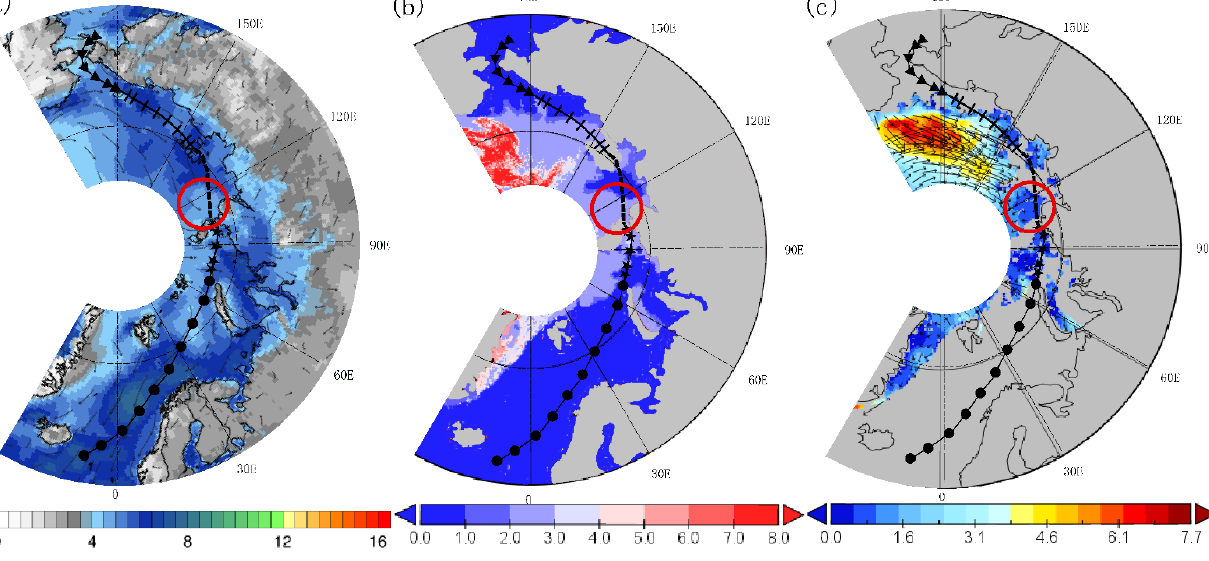
Figure 14. The average wind field ( a ), sea ice age ( b ) and sea ice movement ( c ) of the NEP in the Arctic in July 2007.